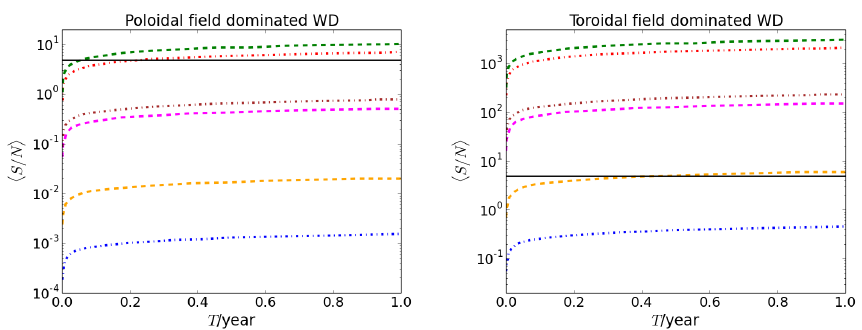
Figure 9. SNR as a function of integration time for XTE J1810-197 assuming χ = 45 ◦ . The first, second and fifth lines from top correspond to a WD with radius 3000 km for BBO , DECIGO and ALIA respectively, while third, fourth and sixth lines from top represent a WD with radius 1000 km for BBO , DECIGO and ALIA respectively. The solid black line corresponds to (cid:104) S / N (cid:105) ≈ 5. See